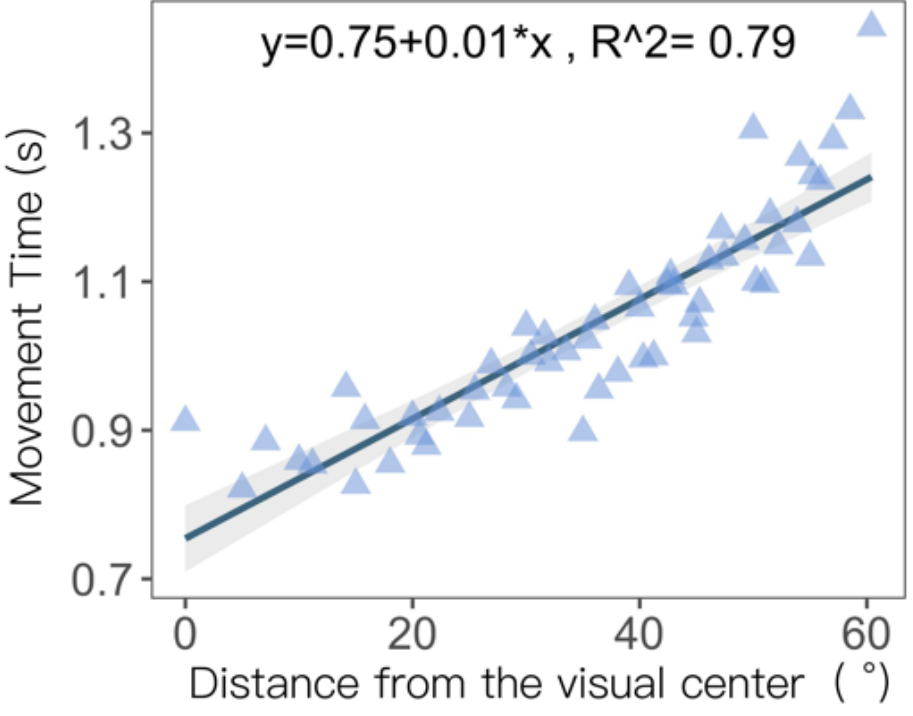
Figure 3. Correlation analysis regarding the movement time and the distance between the position of the target and the visual center.